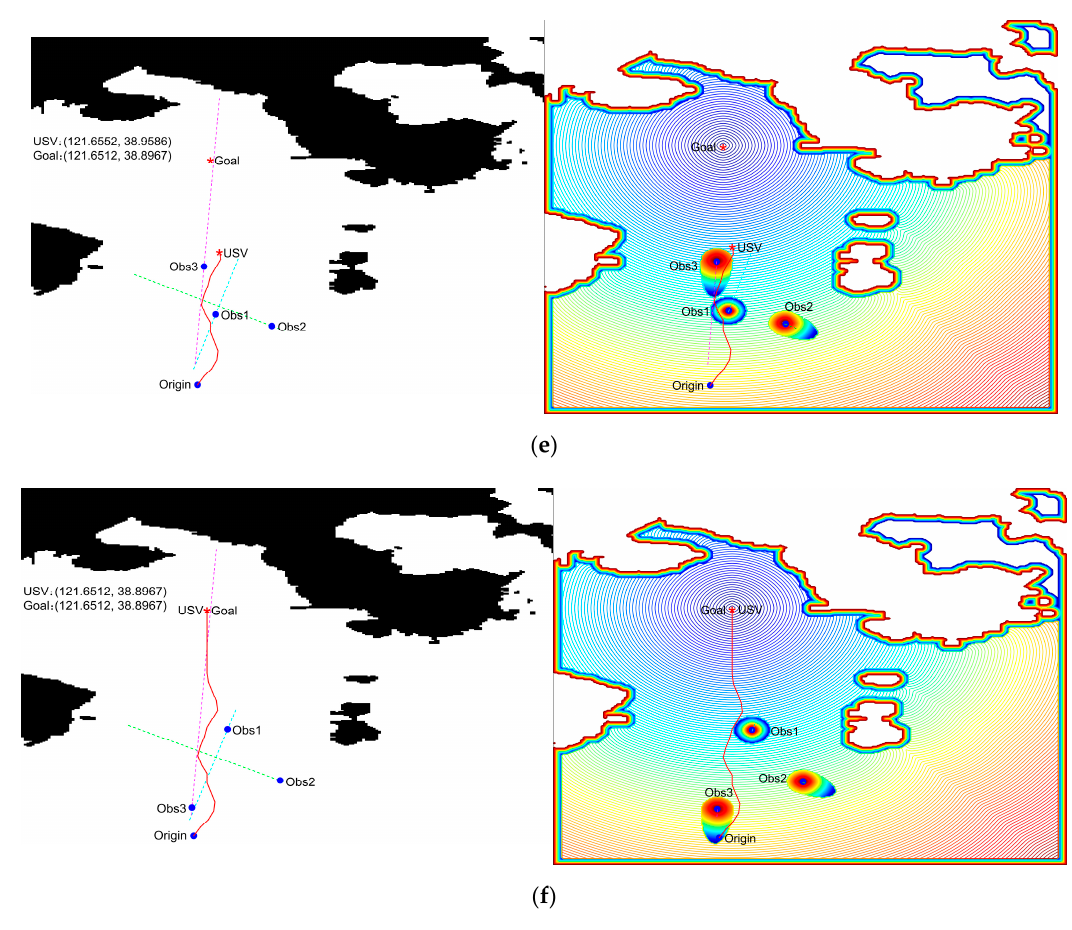
Figure 26. Local dynamic programming trajectory and corresponding potential field of USV: ( a ) simulation cycle 5; ( b ) simulation cycle 9; ( c ) simulation cycle 10; ( d ) simulation cycle 14; ( e ) simulation cycle 16; ( f ) simulation cycle 26.